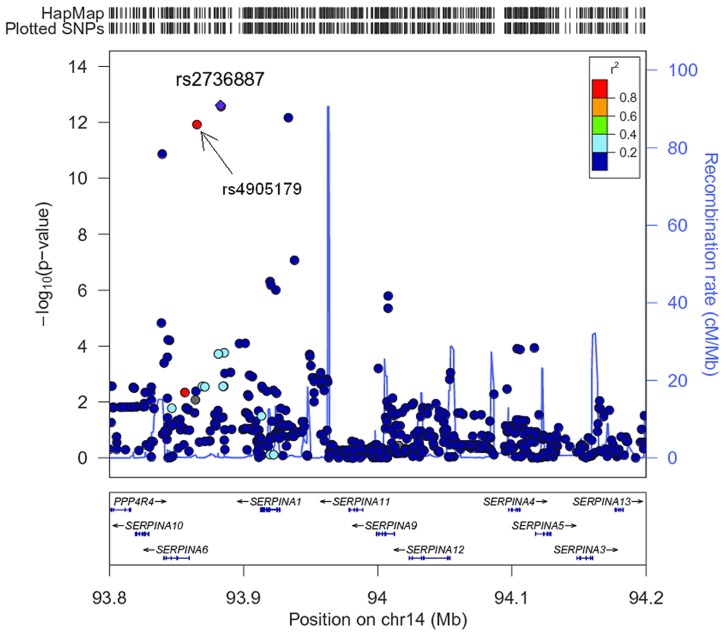
Regional plot for the SERPINA gene cluster (93.8–94.2 Mb on chromosome 14q32.13, reference panel: NCBI build 36.3).Presented are -log(10) p-values and LD (r2) with top-ranking SNP rs2736887 (purple diamond) for all SNPs in this region. The blue line shows recombination rate.